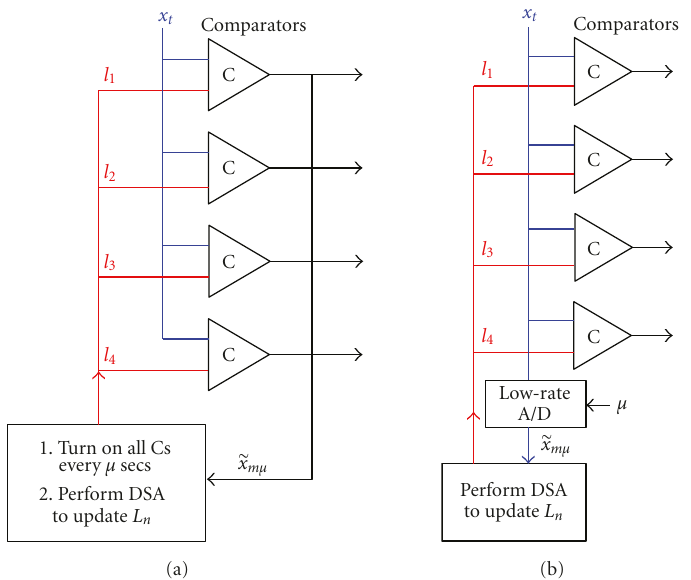
Figure 3: Two methods of tracking input to implement DSA. (a) All comparators are turned on once every μ seconds, and the approximated input (cid:17) x mμ is send to the digital circuit to evaluate DSA. (b) A low-rate ADC keeps track of input x t every μ seconds.